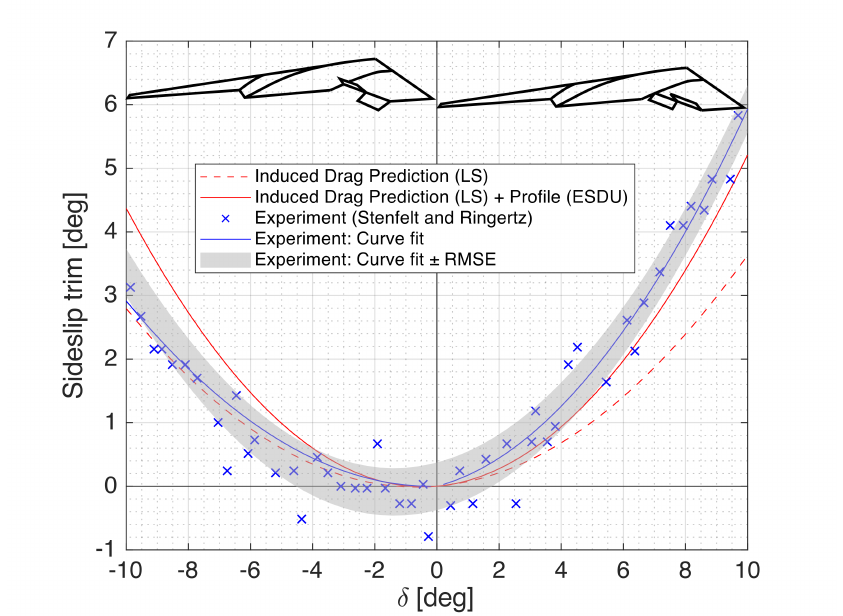
Figure 2. Comparison of predicted yawing moment against experimental results for opposing deflections of dual surfaces on the starboard wing. Positive deflection is outer control surface TEU and inner control surface TED (see inset). For positive deflection, the sideslip trim closely follows the lower bound on the uncertainty from the experiment. However, for negative deflections, the yawing moment is over predicted for defection greater than six degrees ( δ > 6 ◦ ). This is due to the reduction in effectiveness of the outer control surface due to the increasing influence of spanwise